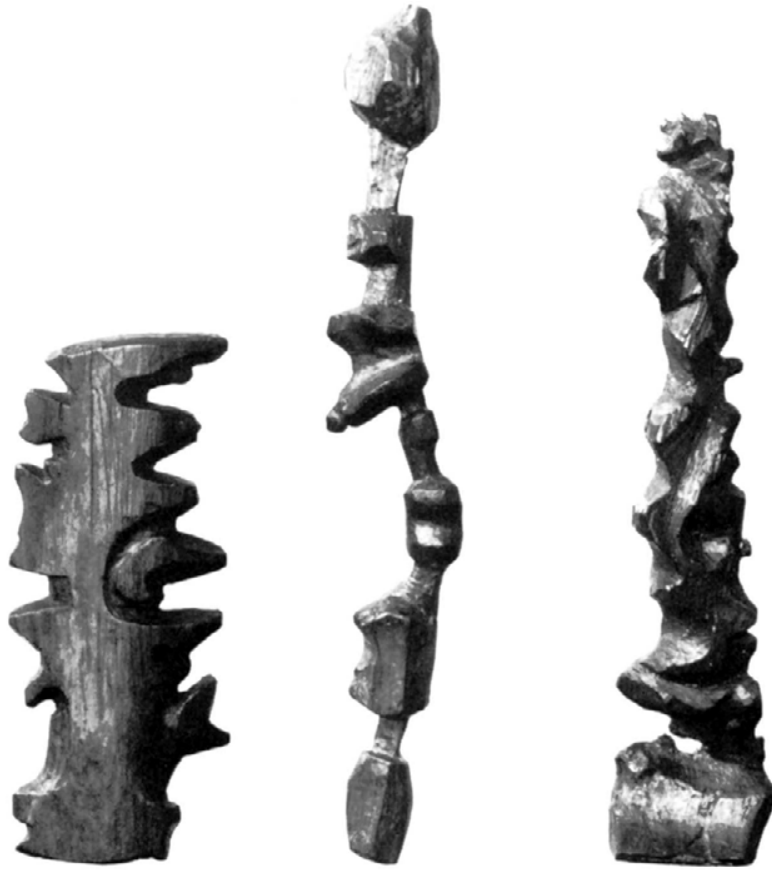
“Ammassalik” wooden maps of the East Greenland coast. Source: Robert Petersen, “East Greenland before 1950”,